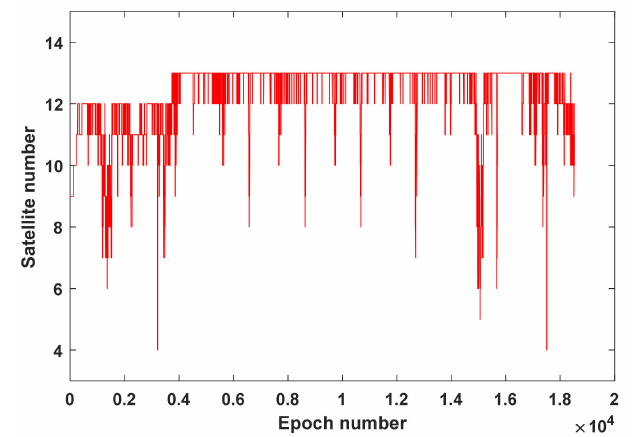
Figure 7. BDS-2 SPP ( left ) and PPP ( right ) RD velocity errors of air-borne experiment. Blue circles in the left plot denote nine airplane turns.